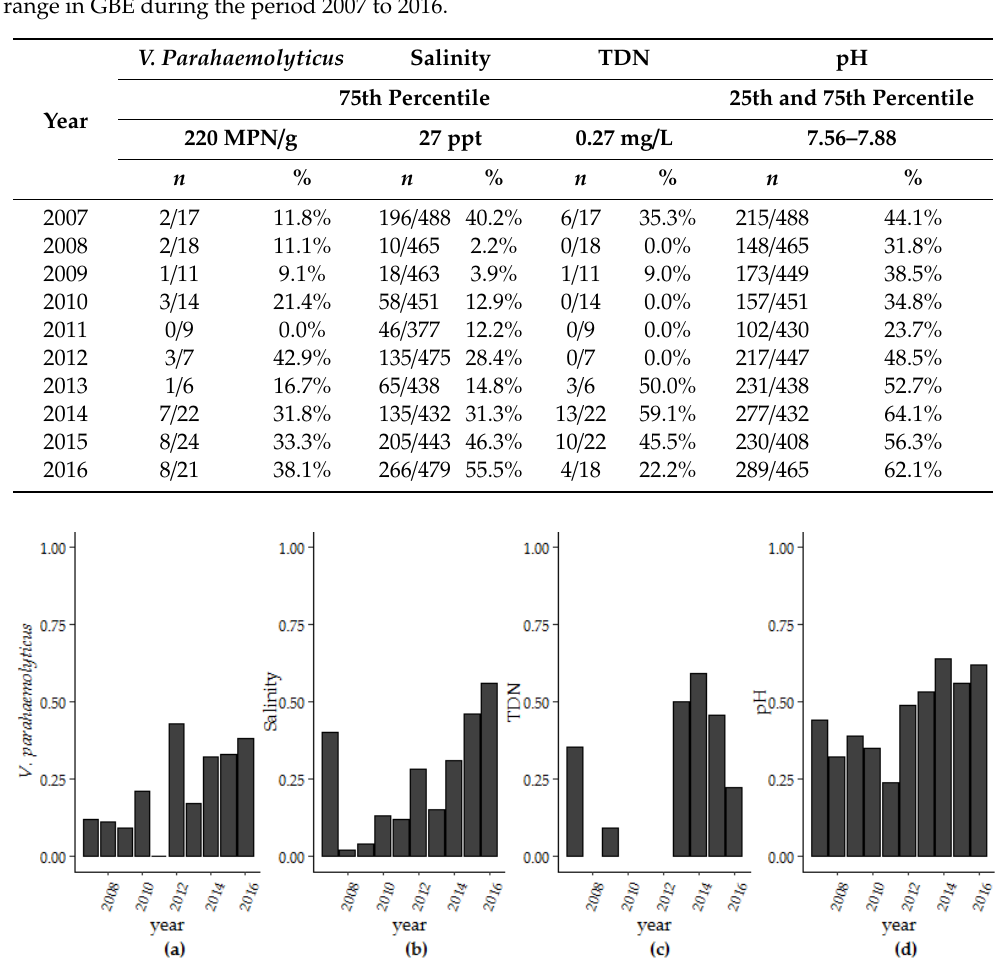
Figure 4. The number of observations per year above the 75th percentile for ( a ) V. parahaemolyticus concentrations, ( b ) salinity, ( c ) TDN and between the 25th and 75th percentile for ( d )